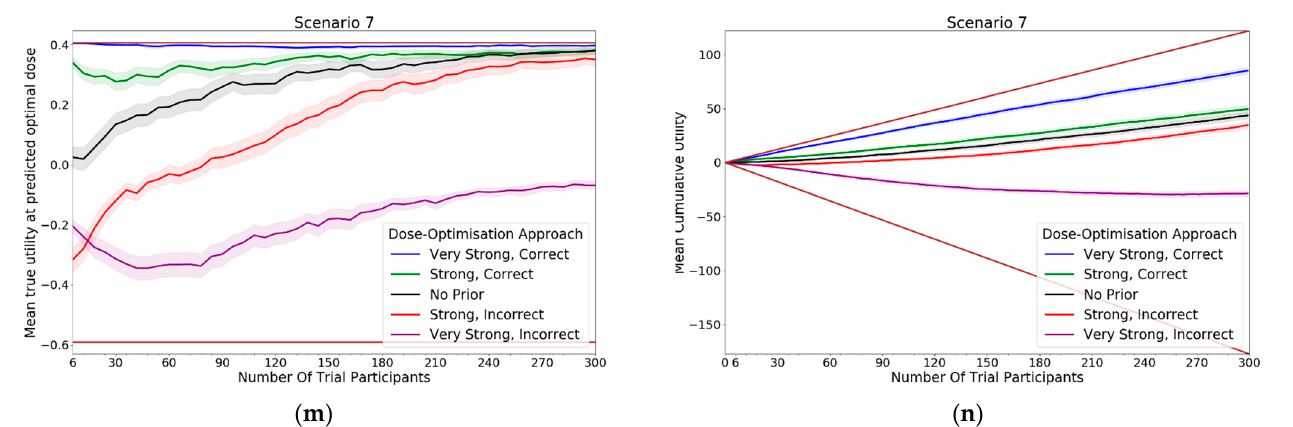
Figure 13. Mean true efficacy at the predicted optimal dose (S1–6, left), mean cumulative sum of efficacy (S1–6 6, right), mean true utility at the predicted optimal dose (S7, left), and mean cumulative sum of utility (S7, right) against trial size for all seven objective 4 scenarios (Scenario 1 ( a , b ), Scenario 2 ( c , d ), Scenario 3 ( e , f ), Scenario 4 ( g , h ), Scenario 5 ( i , j ), Scenario 6 ( k , l ), Scenario 7 ( m , n )). These are the mean values and 95%CI values across 100 simulations. For the true efficacy/utility at the predicted optimal dose plots (left), the brown lines show the minimum and maximum possible efficacy/utility that could be achieved in that scenario. For the cumulative efficacy/utility plots (right) the brown lines represent the maximum and minimum cumulative efficacy/utility sum that could be expected for that scenario.